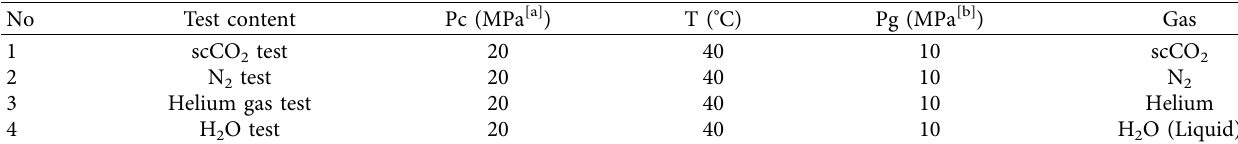
Figure 3: (a) Schematic diagram of the experimental system, (b) main components of the experimental system, and (c) specimen set up between the top and the bottom plates in the confning pressure barrel. Table 1: Te experimental parameters.